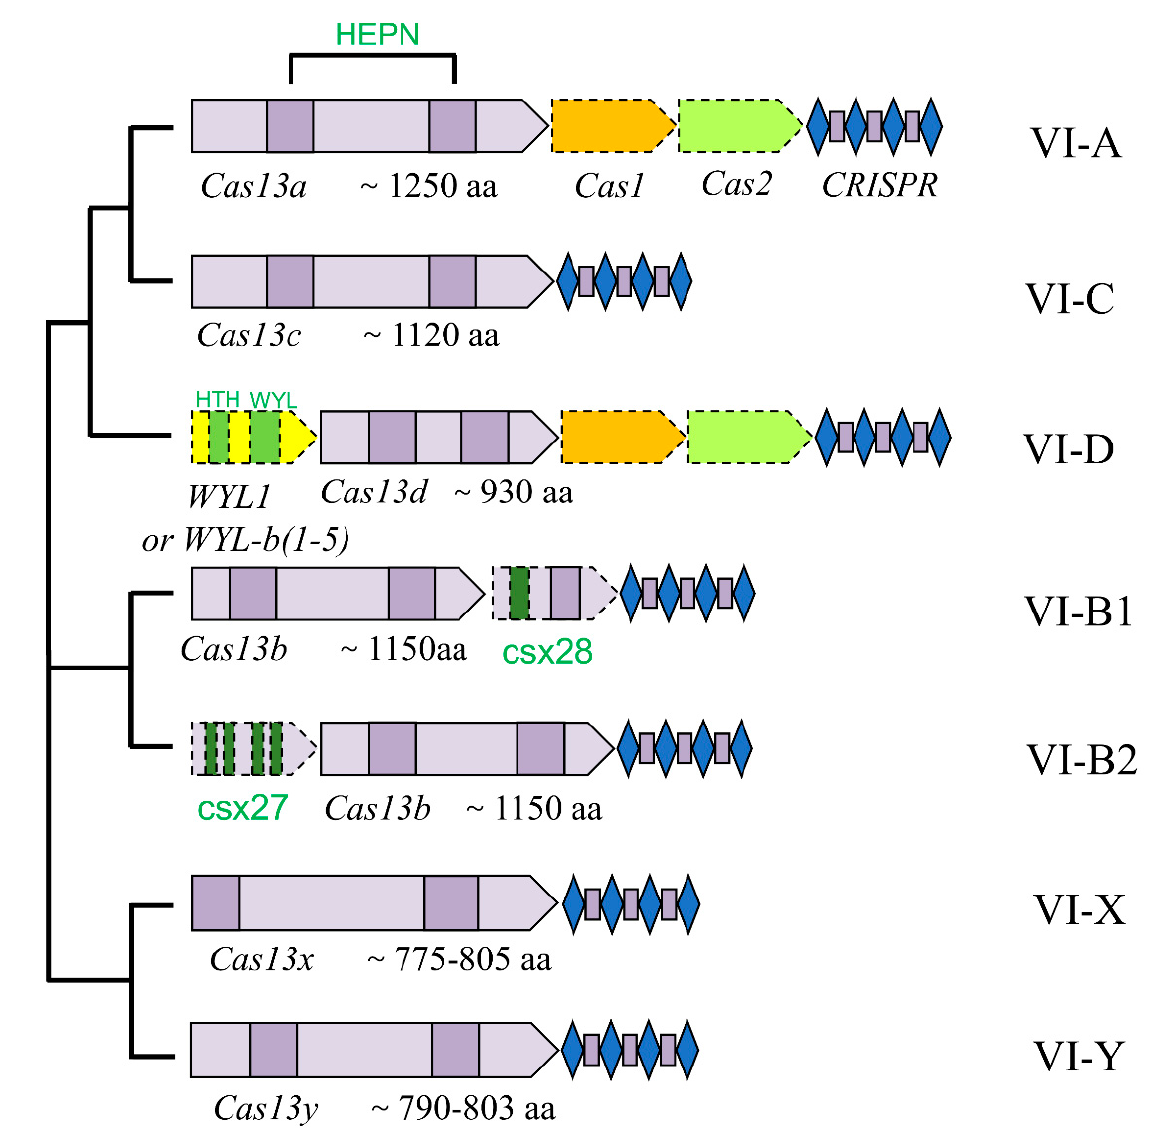
Figure 2. The architecture of CRISPR locus of VI CRISPR-Cas systems and their phylogenetic relationships. The class 2 systems (type VI CRISPR systems) consist of a single, comparatively larger Cas effector protein and CRISPR locus, which can be divided into four subtypes VI-A, VI-B1, VI-B2, VI-C, VI-D, VI-X, and VI-Y. Different colors represent different functional domains in this phylogenetic tree. The HEPN domains of each effector are represented by dark purple squares separated by other structural units. Grey rectangles denote CRISPR direct repeats (DRs), and dark purple squares indicate spacer sequences. The size of each effector and its corresponding conserved domain are indicated as the gene box.